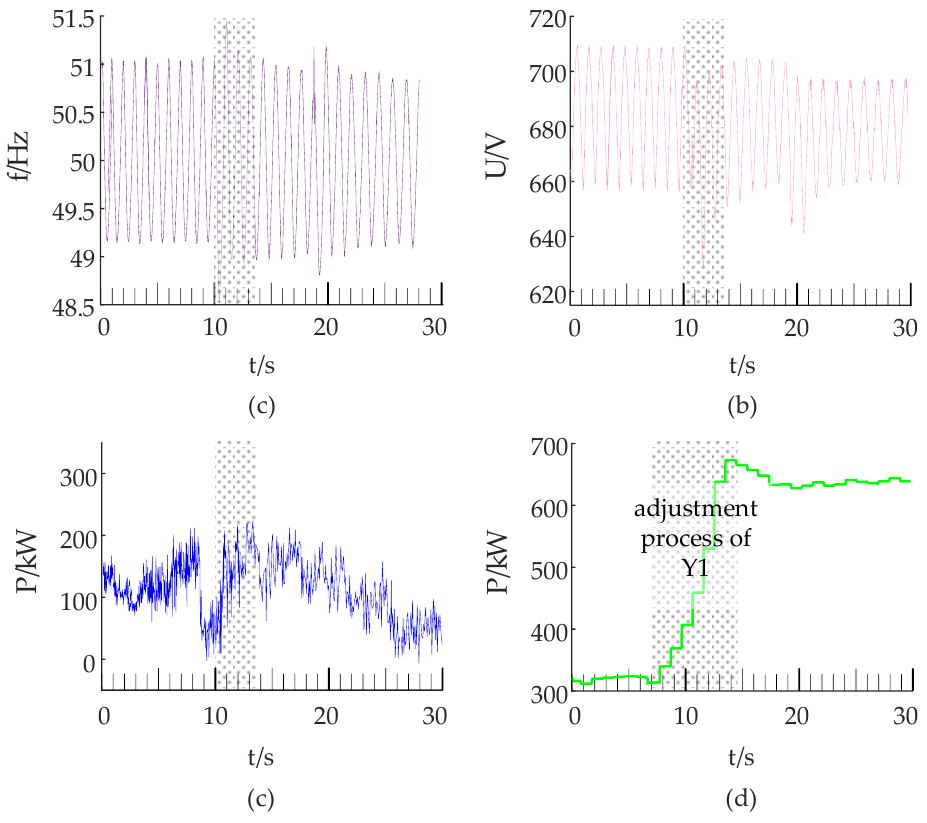
Figure 11. ( a ) system frequency, ( b ) system voltage, ( c ) active power of Gd, ( d ) active power of Y1.